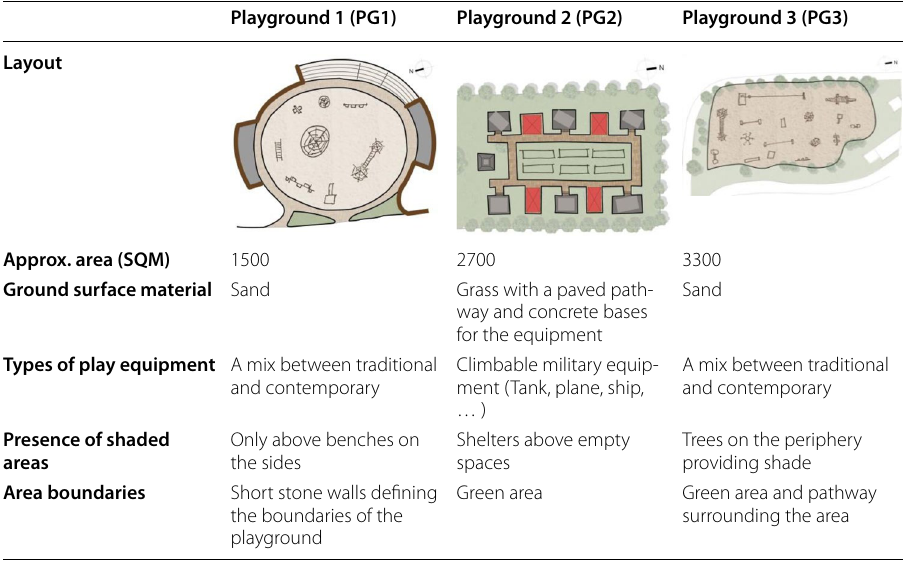
Table 2 Difference in physical characteristics of the three investigated